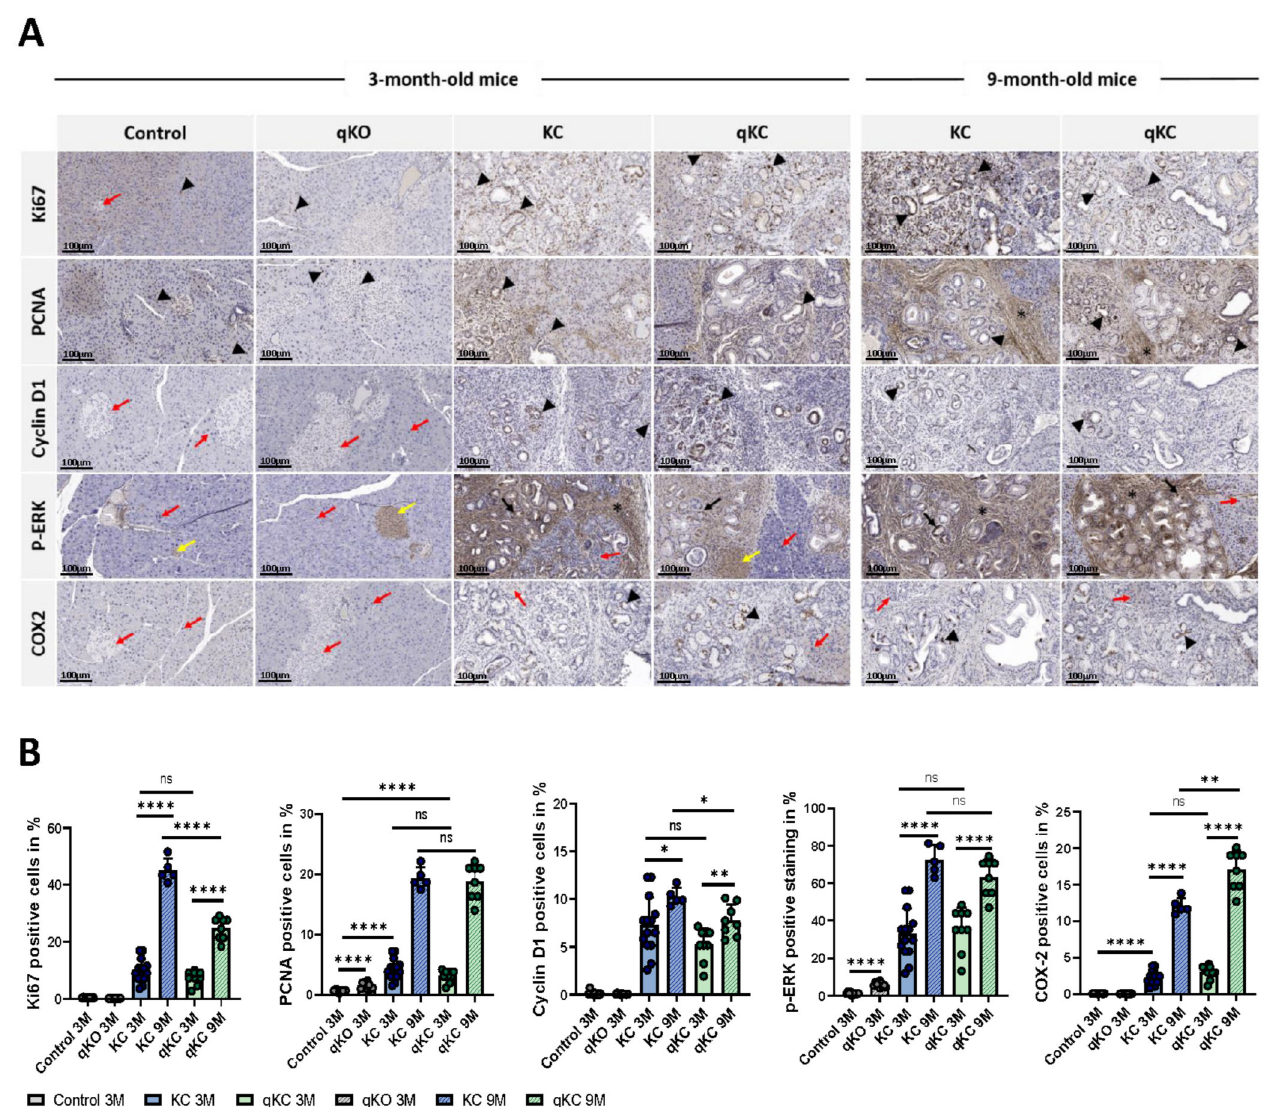
Figure 8. Signaling pathways in KC and qKC mice. ( A ) Representative immunohistochemical staining images for Ki67, PCNA, cyclinD1, p-ERK, and COX-2 in the pancreases of control, qKO, KC, and qKC mice at 3 months of age, and 9 month old KC and qKC mice. Strong nuclear staining of Ki67 detected in PanIN lesions of KC and qKC mice, and acinar cells of control, qKO, KC, and qKC animals (black arrowheads). No Ki67 expression in islets of control mice (red arrow). Positive staining of PCNA in acinar cells, islets, and ducts in all experimental animals (black arrowheads). Absence of cyclin D1 immunoreactivity in control and qKO mice (red arrows). Strong nuclear labeling of cyclin D1 in all KC and qKC pancreases (black arrowheads). P-ERK expression visible in islets of control, qKO, KC, and qKC animals (yellow arrows). In addition, strong positive staining of p-ERK noted in PanINs (black arrowheads) and stroma of KC and qKC mice (black asterisks). No expression of p-ERK in acinar cells of all experimental animals (red arrows). Cytoplasmic labeling of COX-2 detected only in PanIN lesions occurring in KC and qKC mice (black arrow). Absence of COX-2 immunoreactivity in control and qKO pancreases. Scale bars represent 100 µ m. ( B ) Histological score of Ki67-, PCNA-, cyclin D1-, p-ERK-, and COX-2-positive cells in pancreas of experimental mice groups (control mice, n = 10; qKO mice, n = 10; KC mice of age 3 months, n = 14, 9 months, n = 5; qKC mice of age 3 months, n = 9, 9 months, n = 8). Error bars represent mean ± SD; Error bars represent mean ± SD; * p < 0.05, ** p < 0.01, *** p = 0.0001, **** p < 0.0001; ns = not significant (Student’s t